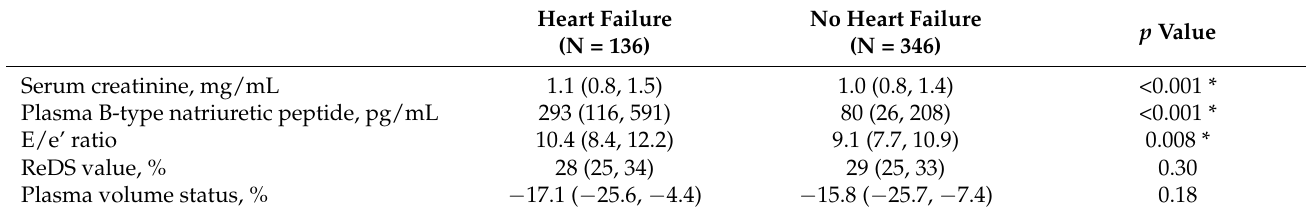
Table 3. Comparison between those with and without heart